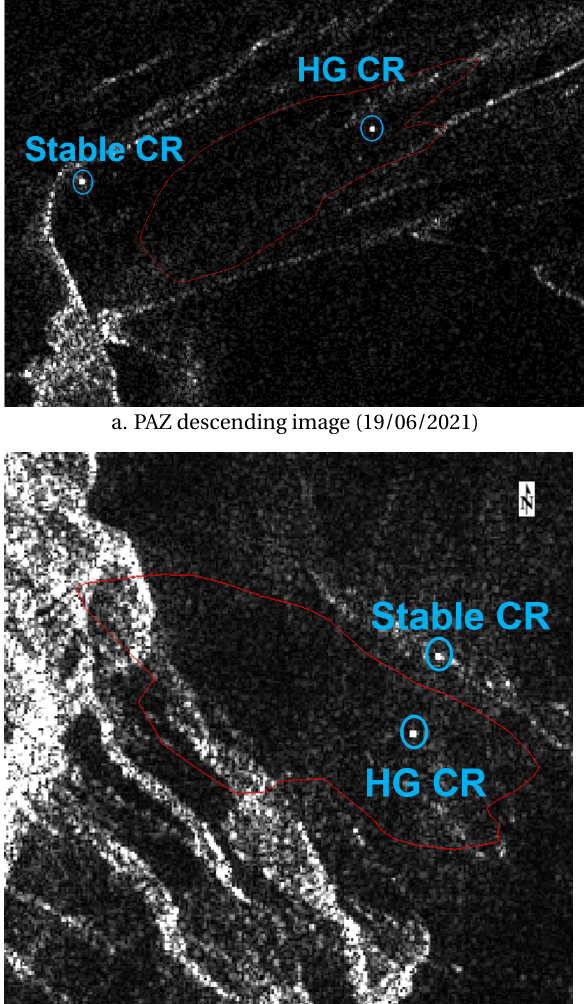
Figure 6. Visibility of the CRs on the HG (red polygons) in PAZ images in SAR range-azimuth geometry.